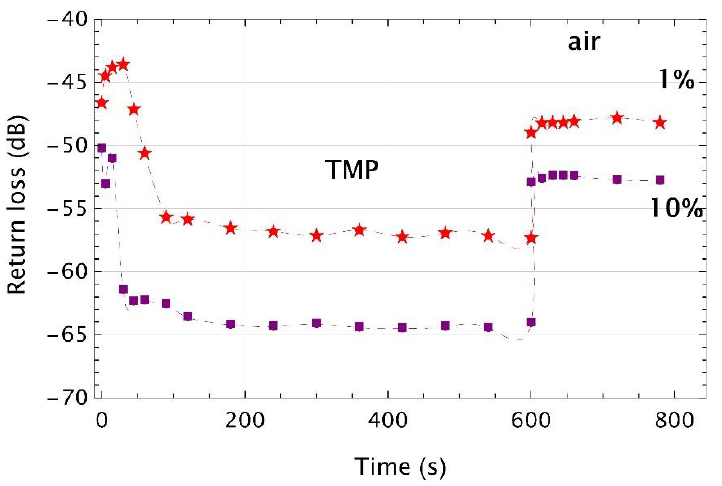
Figure 10. Time responses of the VIS microtips made with the monomer mixture enriched with TEOS cross-linking additive and with APTES treated optical fiber exposed to vapors of the TMP of a volume of 50 µL. Markers are experimental points, while the dashed lines are their cubic polynomial interpolations.